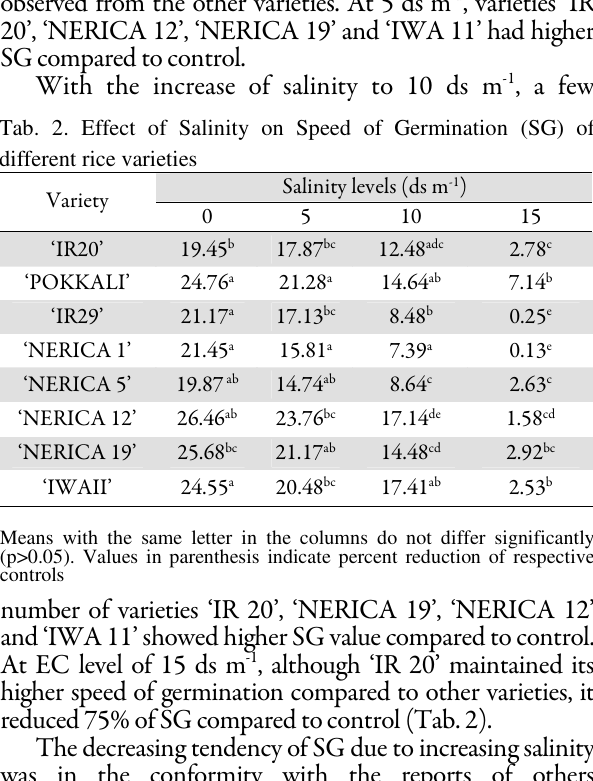
Means with the same letter in the columns do not differ significantly (p>0.05). Values in parenthesis indicate percent reduction of respective controls